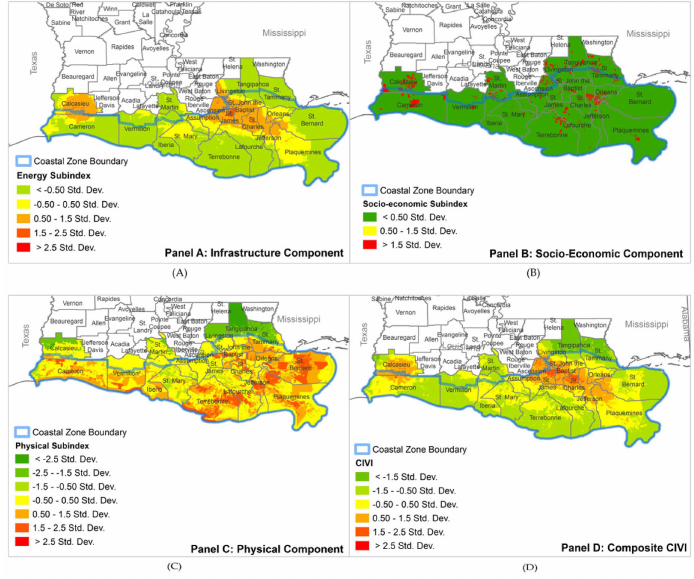
Figure 4. Louisiana-based CIVI. Results are categorized in terms of standard deviations from the mean component score value across all census blocks. Higher values represent higher infrastructure vulnerability measures whereas lower values represent lower infrastructure vulnerability measures. ( A ) Infrastructure component; ( B ) Socio-economic component; ( C ) Physical component; ( D ) Composite